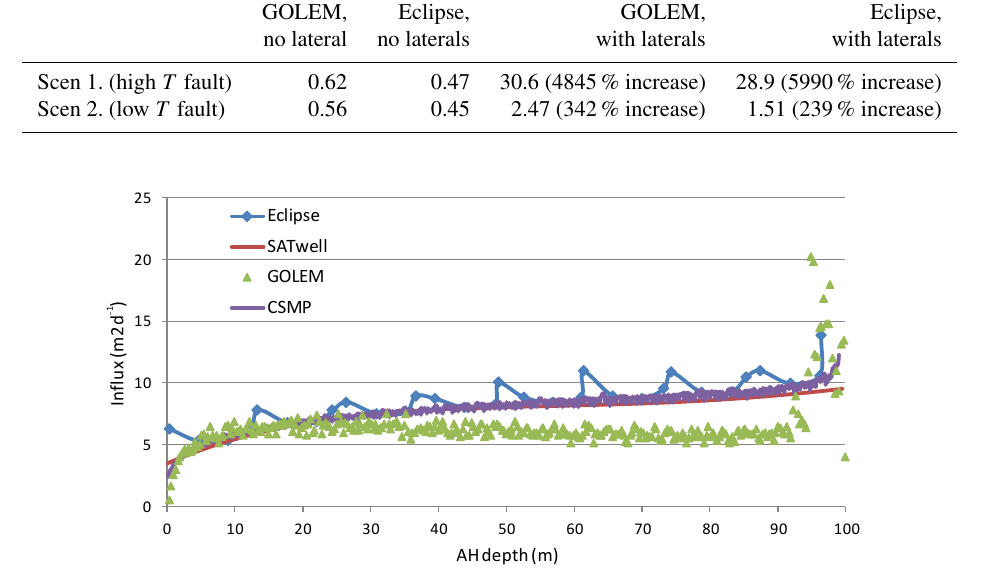
Figure 3. Comparison of the inflow profile for the downward pointed radial (track 13 in Fig. 1) for case 2.